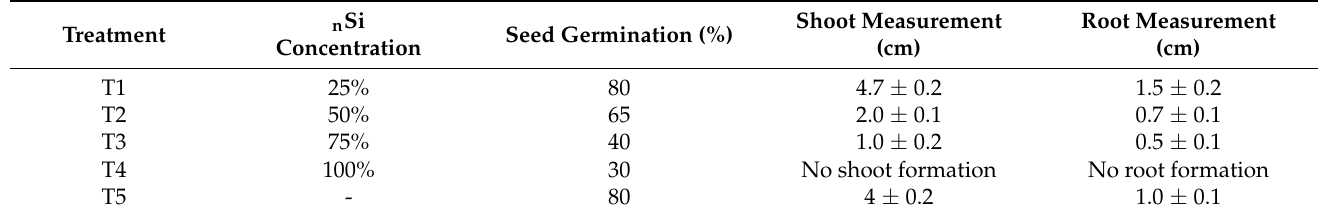
Table 3. Seed-germination